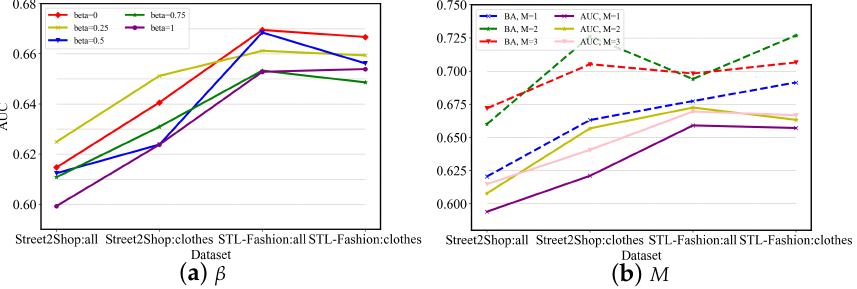
Figure 9. Studies of important hyperparameters. Please note that for ( a ), M is 3. In addition, for ( b ), α = γ = δ = 1 and β is